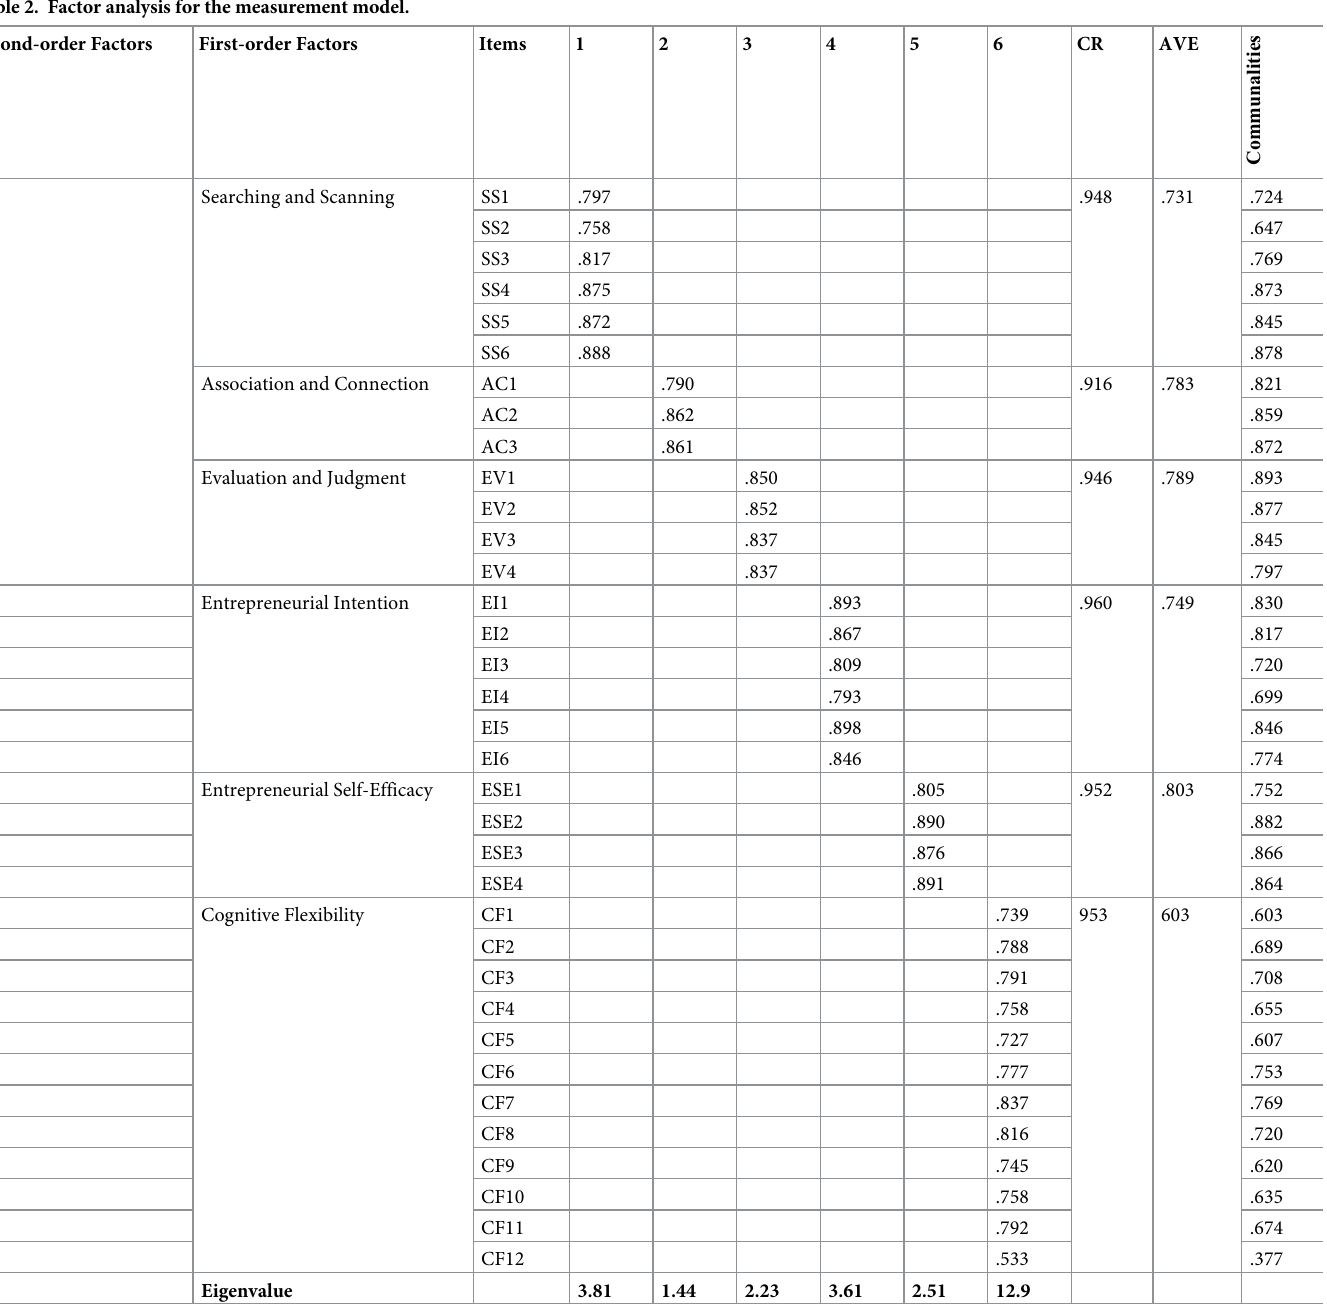
Table 2. Factor analysis for the measurement